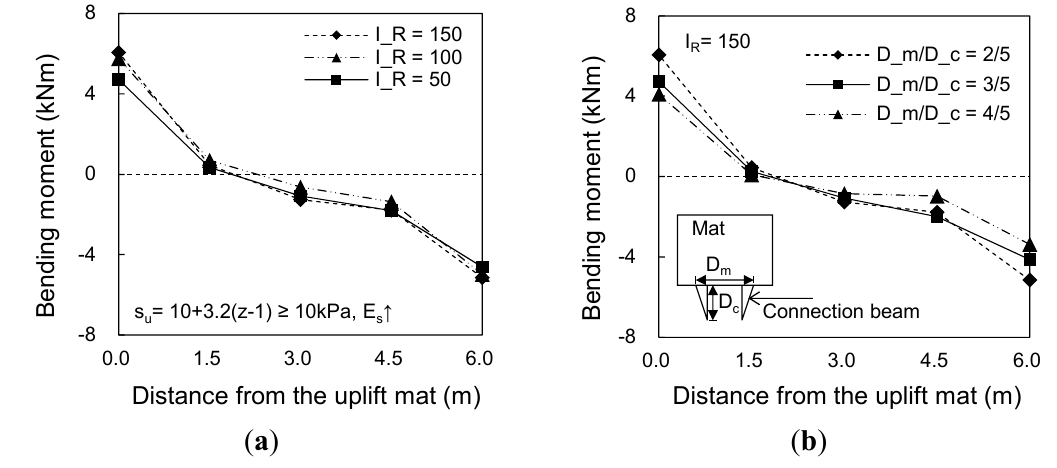
Figure 16. Distribution of bending moment along connection beams: ( a ) bending moment distribution for different soil conditions and ( b ) bending moment distributions for different haunch